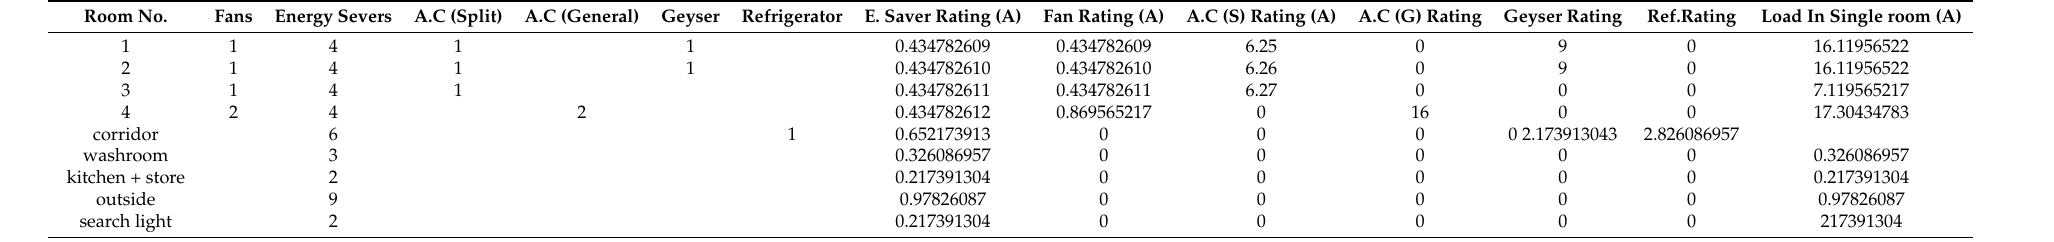
Table 7. Coordinator house existing load data.